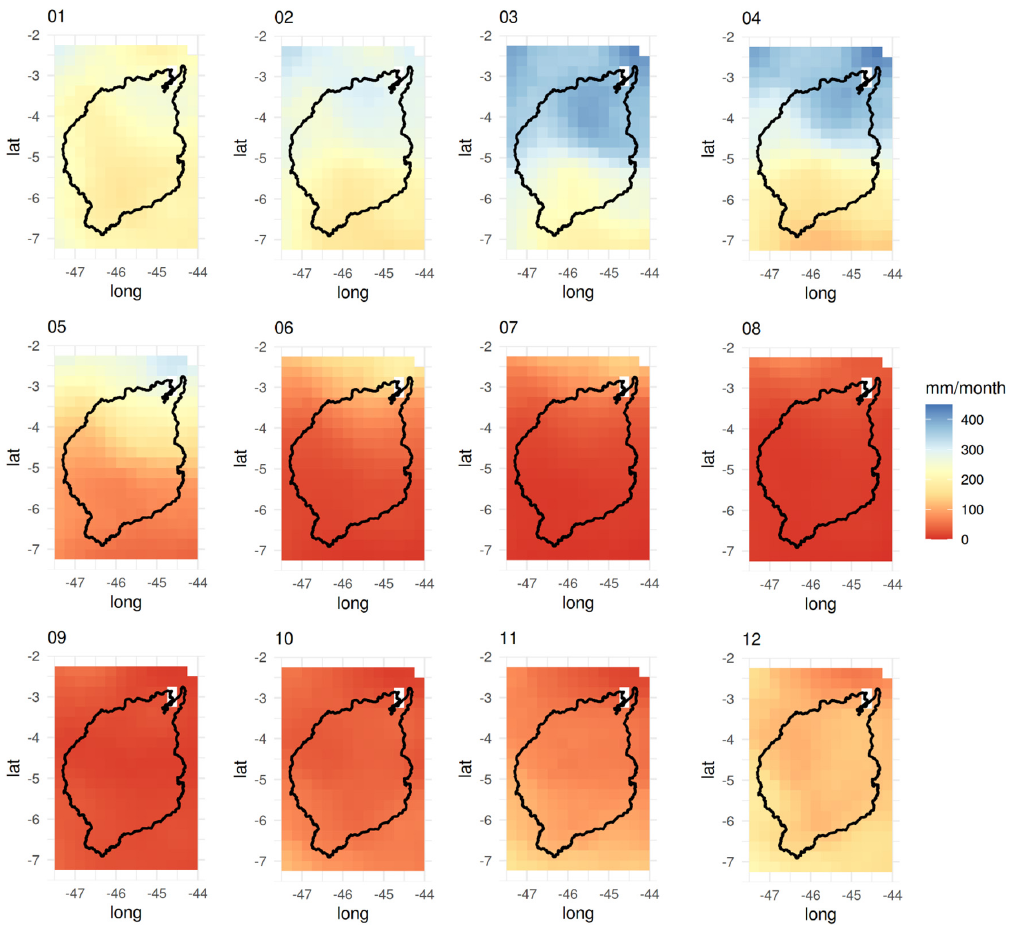
Figure 2. Mean monthly rainfall from 1983 to 2013 from the gridBR reference outputs in the MDB region.